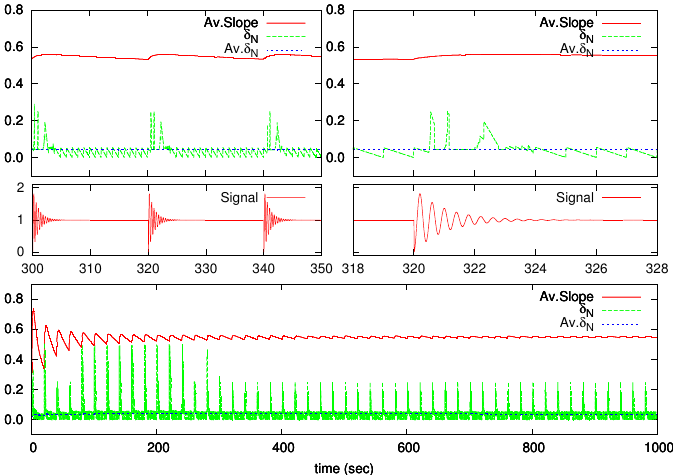
Figure 5. Algorithm behavior for the under-damped High-Oscillating signal. Details for the | ˙ x | and δ N